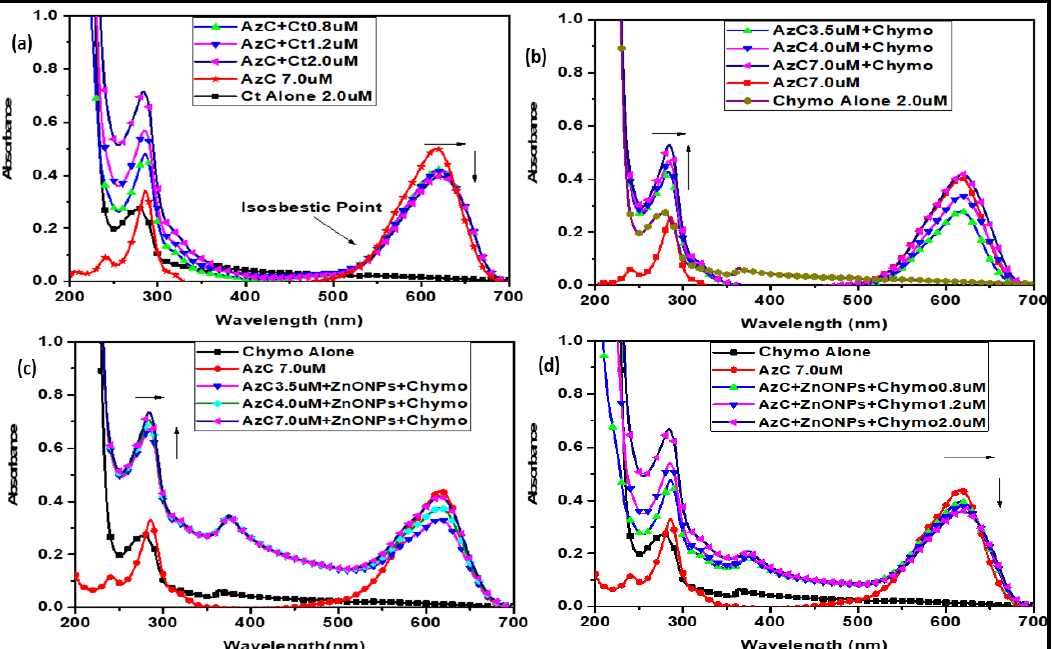
Figure 2. UV ‐ Visible titration Studies: ( a ) Variation of Chymo with constant AzC; ( b ) Variation of AzC with constant Chymo; ( c ) Variation of AzC ‐ ZnONPs with constant Chymo ( d ) Variation of Chymo with constant AzC ‐ ZnONPs.